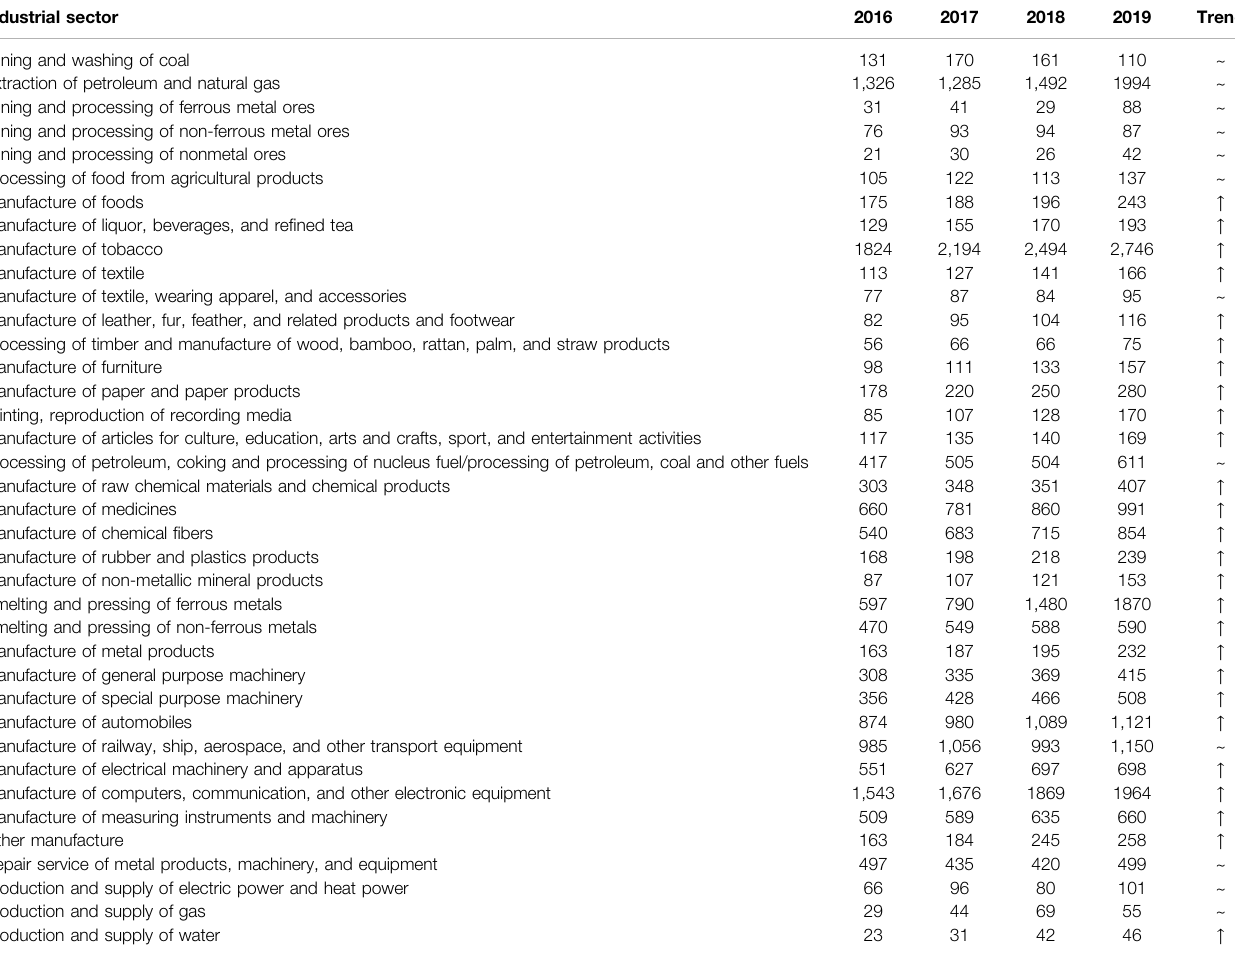
TABLE 2 | Enterprises ’ average expenditure on new products ’ development by industrial sector in China during 2016 – 2019 (10 4 yuan/unit )